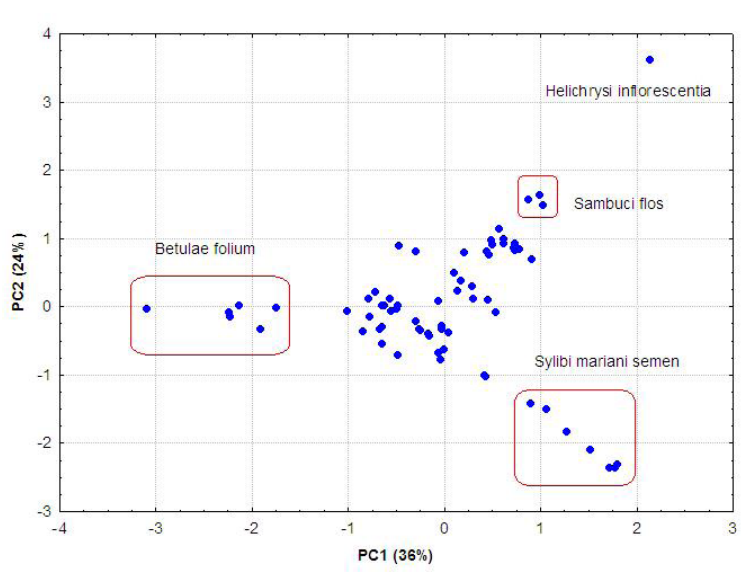
Figure 4: Scatterplot of PC1 vs PC2 for the studied herbal infusions